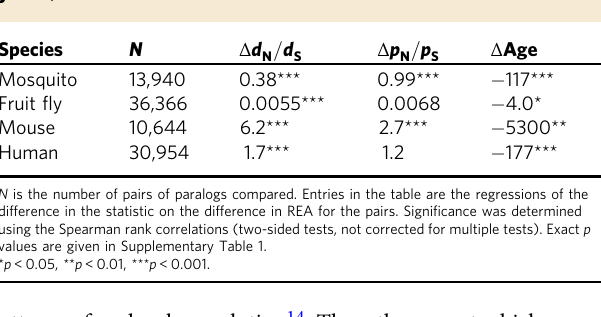
Table 2 The effects of the ages at which pairs of paralogs are expressed on p years).